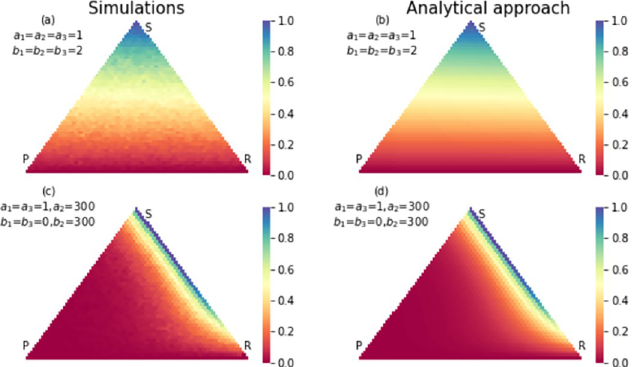
Fig 3. The simulation (a) and analytical (b) results for conditional fixation time of strategy paper for an RSP game with a neutral selection. The size of the population is 50. No wonder that states are close to absorption state P = N , S = 0, R = 0 reaches this absorption state by the fewer steps. In (c) and (d) same results were shown for a strong selection in favor of paper strategy and detriment of rock strategy. Compared to the neutral case, the number of steps for reaching P = N , S = 0, R = 0 is reduced due to strong selection in favor of strategy P.